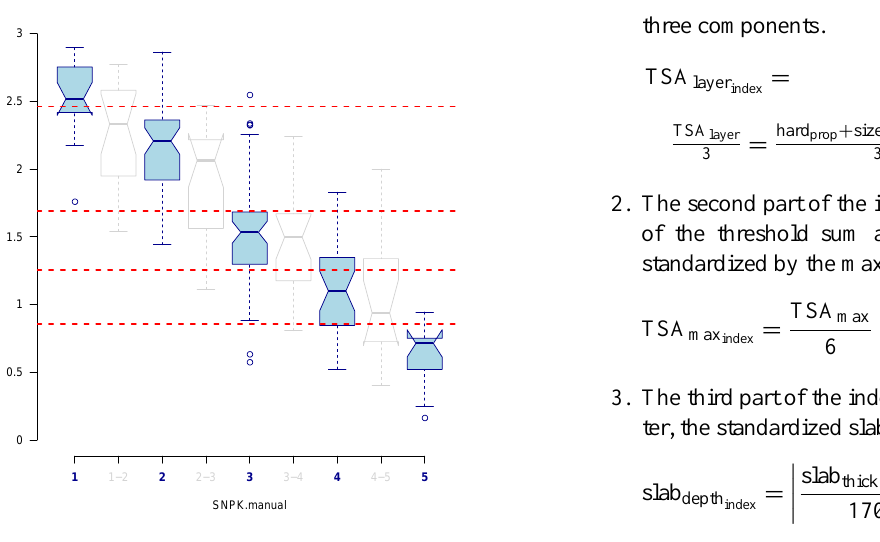
Fig. 2. Box plots showing the SNPK index and the manually clas- sified snowpack structure (SNPK manual , 1 – unfavourable to 5 – favourable). The red lines represent the SNPK index splitting thresh- olds between full SNPK manual classes (light-blue boxes), as ob- tained with the classification tree analysis (Table 5). The correla- tion between the index and the manual classification (including pro- files which were classified with half classes, light boxes) is strong ( ρ = 0.79, p < 10 − 16